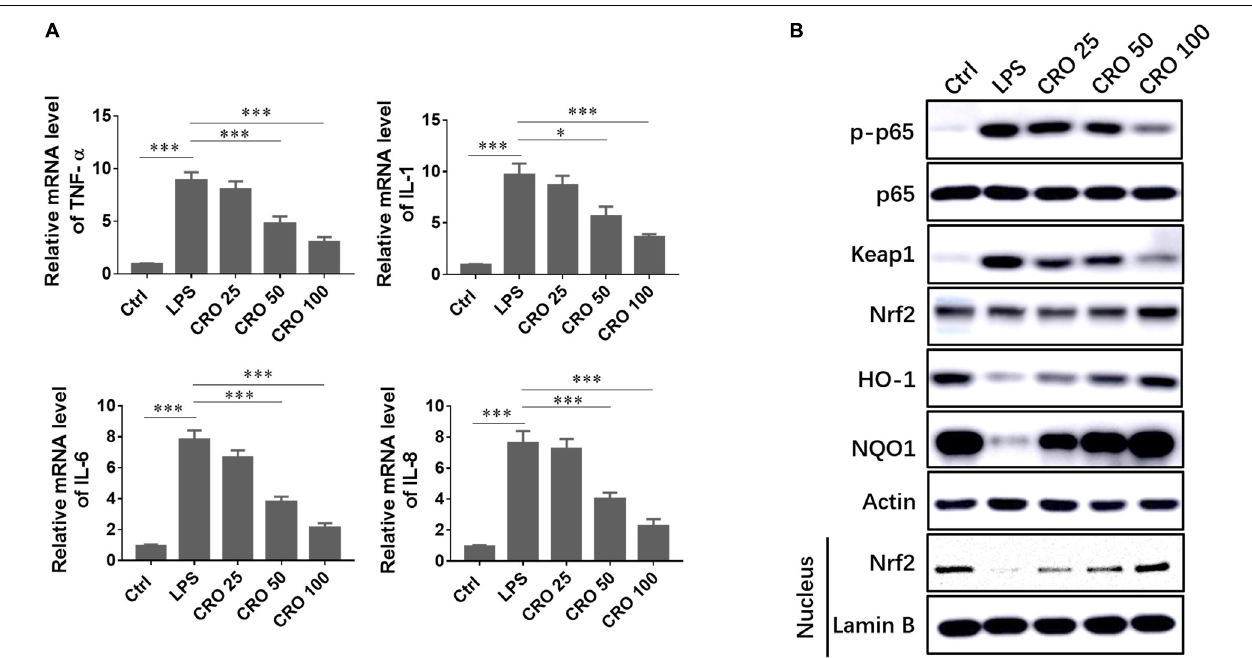
FIGURE 3 | Effect of CRO on the inflammatory response in LPS-induced cardiac sepsis. (A) Effect of CRO on proinflammatory cytokines in LPS-induced H9c2 cells. Data ( n = 3) are presented as the mean ± SEM, *p < 0.05, ***p < 0.001. (B) Effect of CRO on the expression of p-p65, p65, keap1, Nrf2, HO-1, and NQO1 and nuclear expression of Nrf2 in LPS-induced H9c2